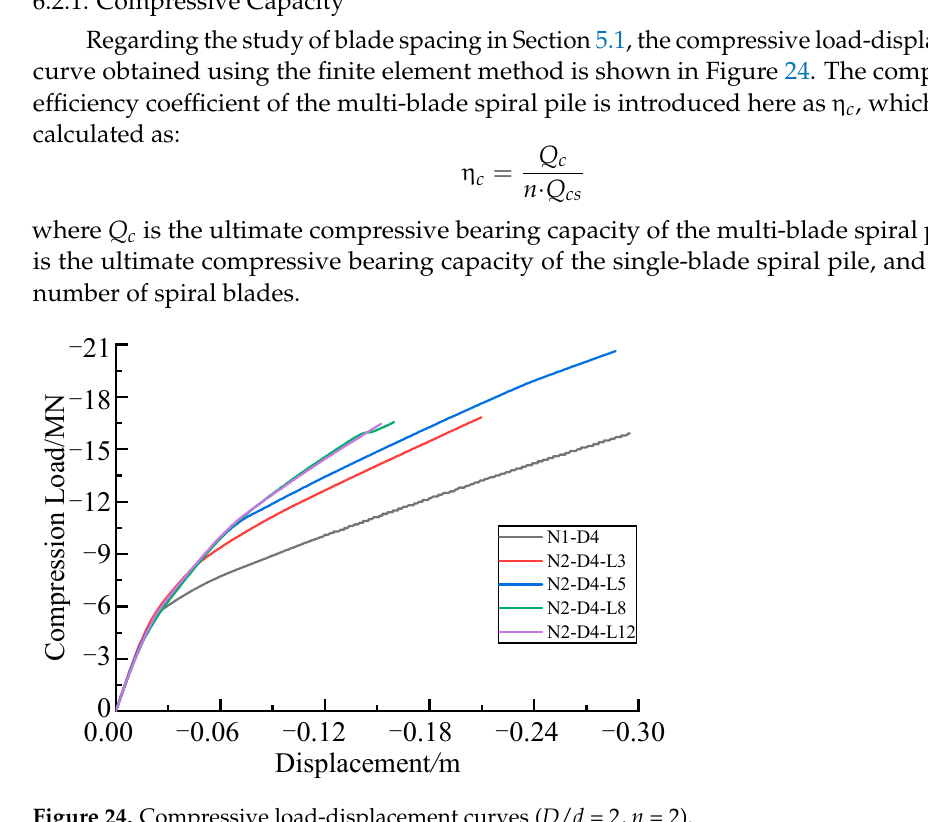
Table 6. Compression efficiency coefficient ( D / d = 2, n =